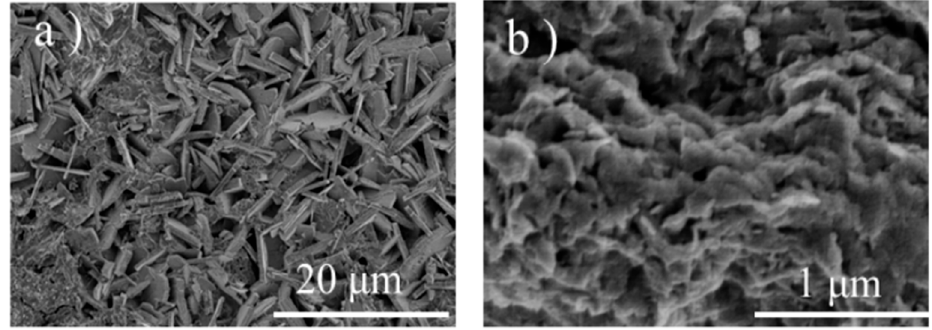
Figure 1. Scanning electron microscopy of biosynthetic FeS 1+x in ( a ) 2 days and ( b ) 6 days.